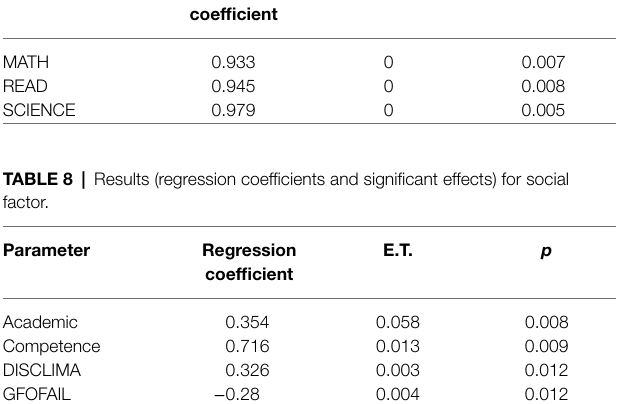
TABLE 4 | Results (regression coefficients and significant effects) for the third independent variable: perception of forgetting time when using digital devices (Perception_time).